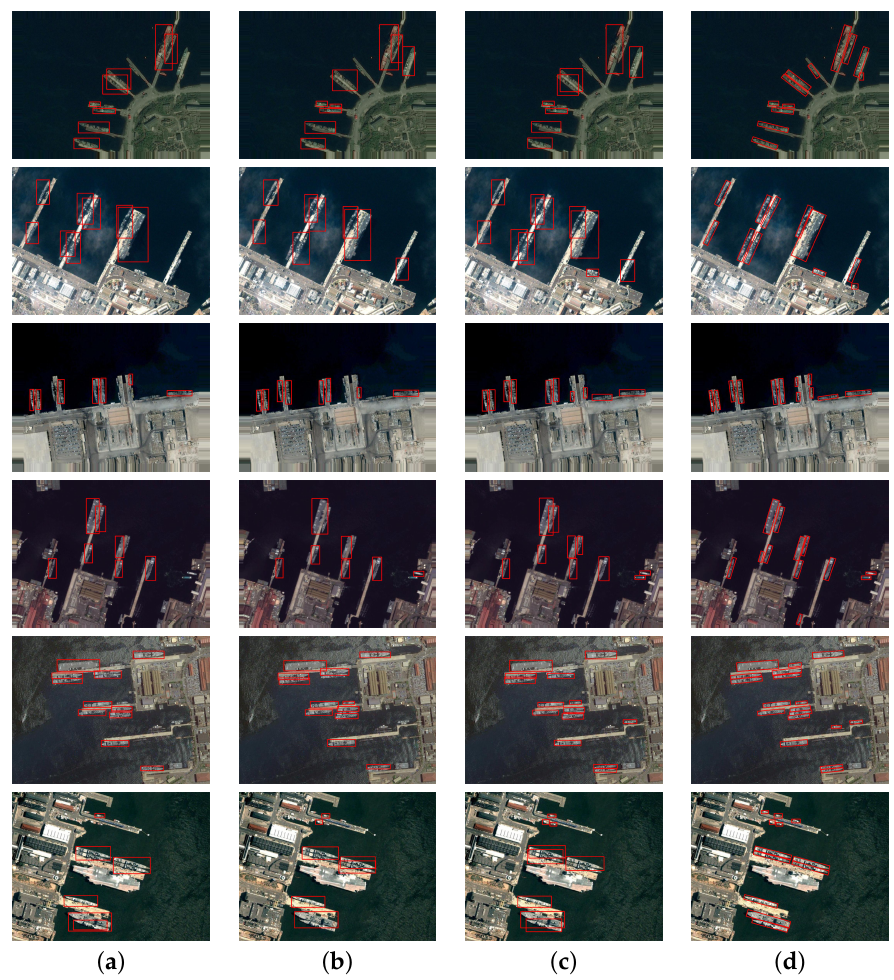
Figure 10. Multi-scale ship detection results of different algorithms: ( a ) method from [40]; ( b ) method from [45]; ( c ) Libra R-CNN; ( d ) our